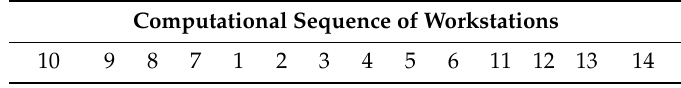
Table 8. Designated sequence of workstations for the analyzed case. Computational Sequence of